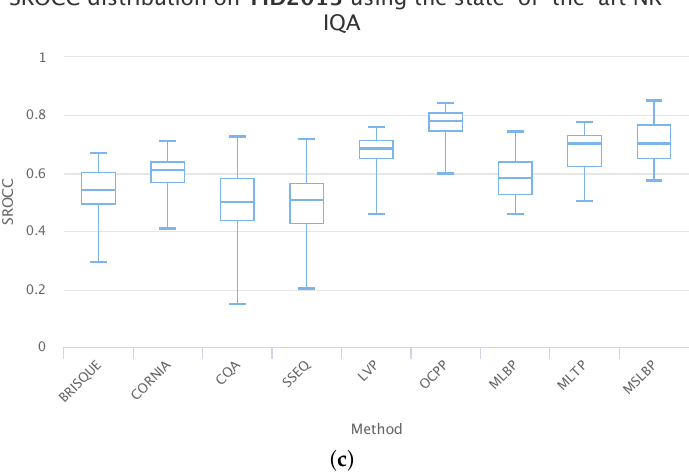
Figure 27. Distribution of average SROCC after 100 simulations using different state-of-the-art methods. ( a ) LIVE2. ( b ) CSIQ. ( c )